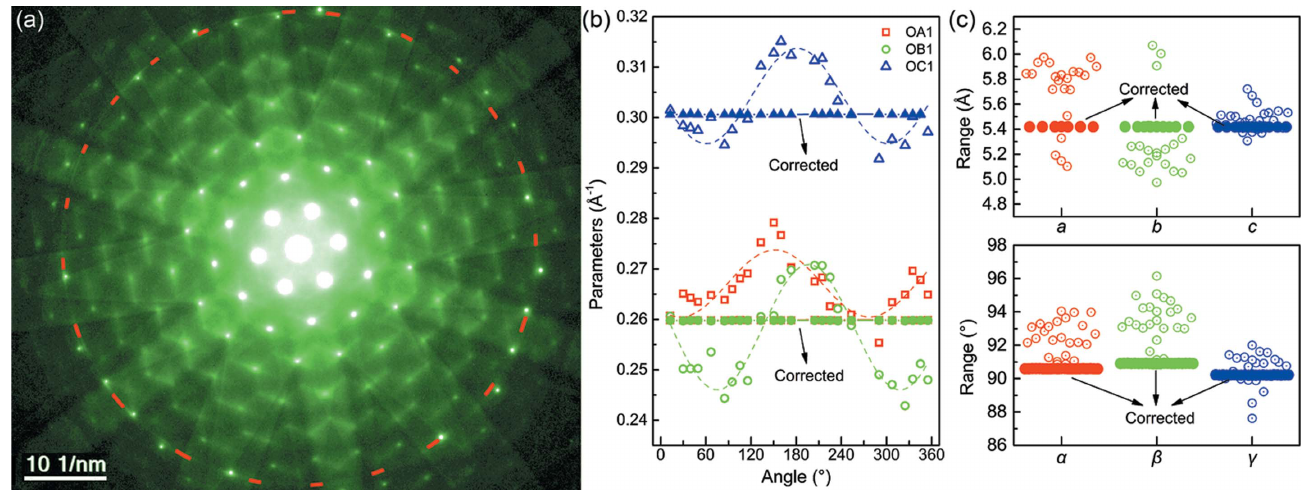
Figure 3 Effect of pattern distortions on unit-cell determination. ( a ) Typical ½ (cid:3) 11 (cid:3) 111 (cid:8) -oriented diffraction pattern with HOLZ reflections of a silicon specimen. The red dashed circle marks the FOLZ ring used for measuring the reciprocal layer spacing H * . ( b ) Angle-dependent measured parameters OA 1 , OB 1 and OC 1 were extracted from 24 HOLZ reflections, and the dotted curves are the sine-function fitted curves. ( c ) Determined unit cells by using sets of angularly measured OA 1 , OB 1 and OC 1 . Where the open symbols in Figs. 3( b )–3( c ) represent the measured parameters of the uncorrected pattern, and the solid ones are those of the elliptical-distortion corrected [Fig. 3( c )]. The open symbols represent the parameters of the uncorrected diffraction pattern, and the solid ones represent those of the elliptical-distortion corrected pattern. Such